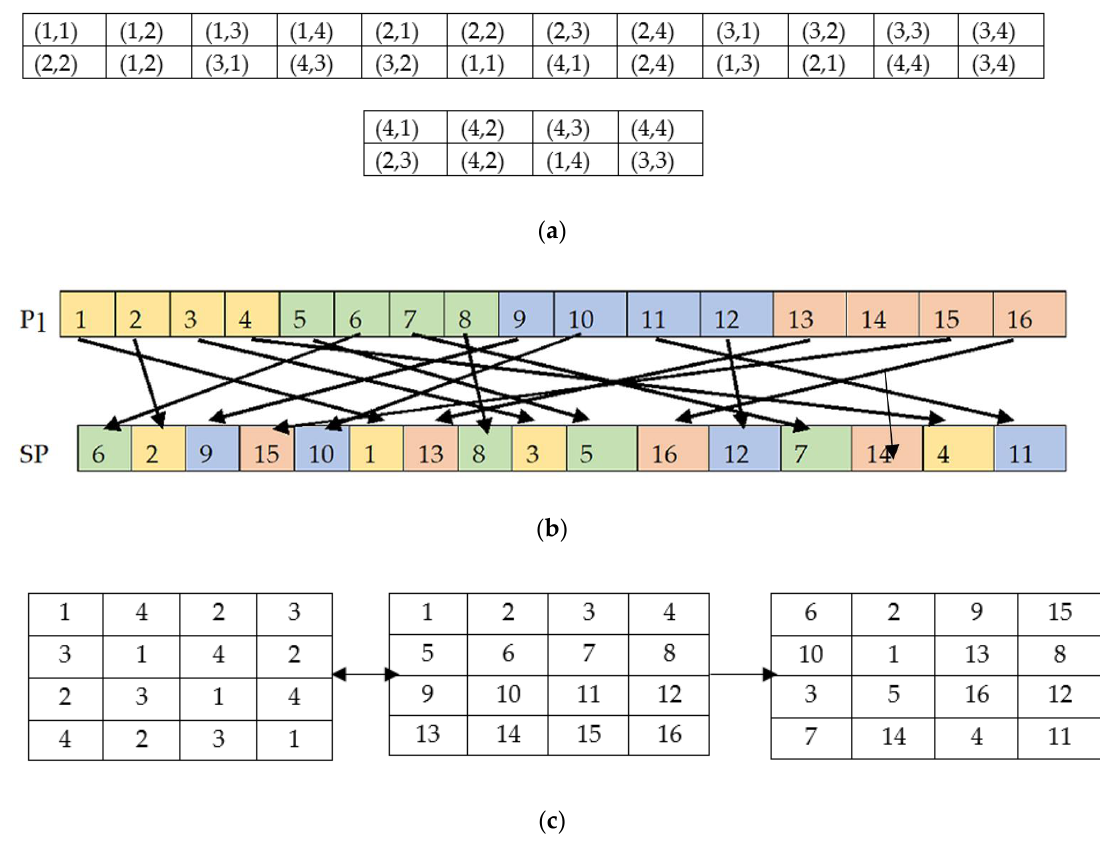
Figure 8. Scrambling process example using 4 × 4 matrix. ( a ) Actual pixel position and its corresponding shuffled pixel position; ( b ) pixels mapping between P1 and SP; ( c ) Matrix view of the scrambling process using S, P1 and SP respectively.